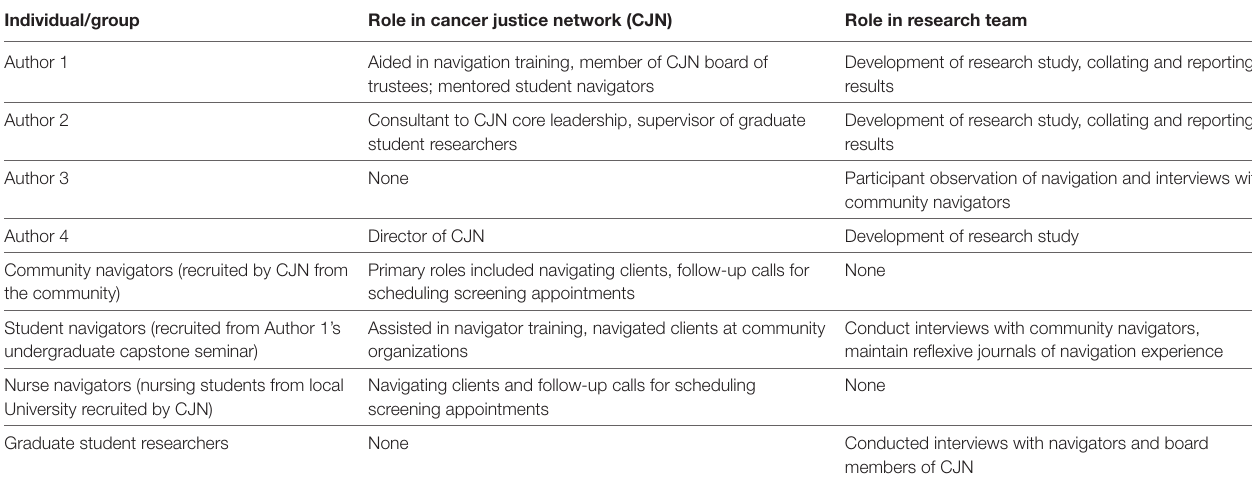
TaBle 1 | Composition of the academic–community collaboration and research teams.